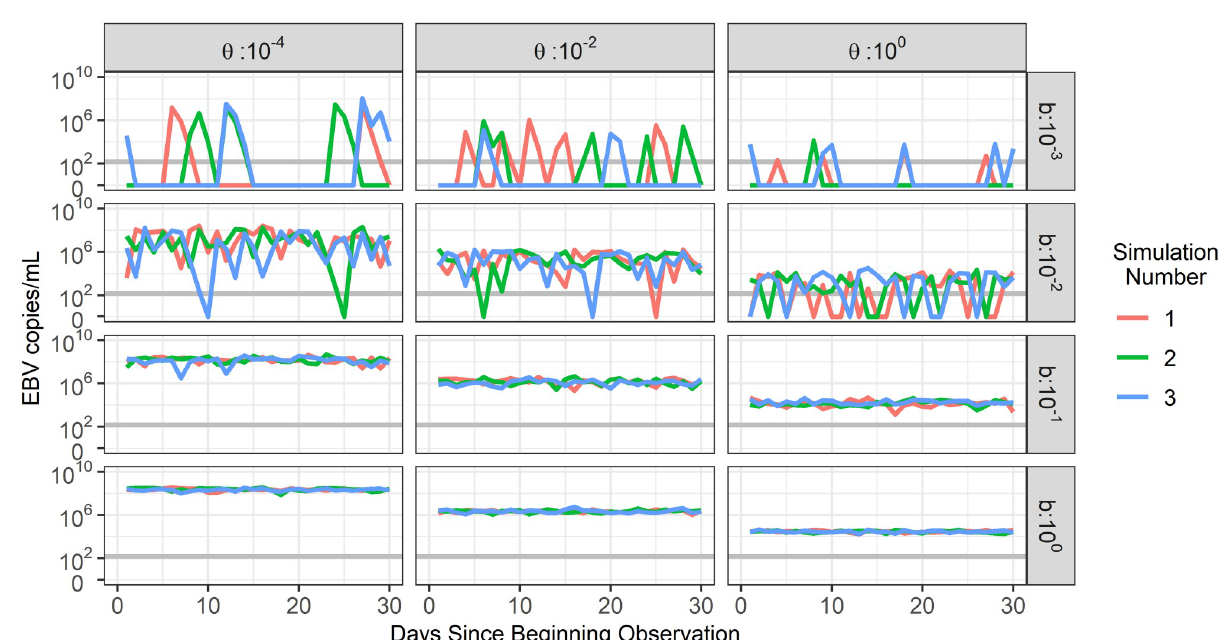
Fig 4. The impact of varying b and θ on model simulation trajectories. Model simulations for different pairings of values for parameters b and θ are shown (units of cell day − 1 and day − 1 respectively). Simulations reproduce the stochastic nature of the data and are able to capture a wide variety of EBV shedding traits. For all simulations, β = 50 day − 1 , f = 0.1 day − 1 cell − 1 , α = 200 cells, δ = 0.1 day − 1 , p = 10 4 virions day − 1 ml − 1 cell − 1 , and c = 6 day − 1 . The grey horizontal line represents the qPCR threshold of detection. All simulated viral loads below this threshold were set to zero to match with participant data.